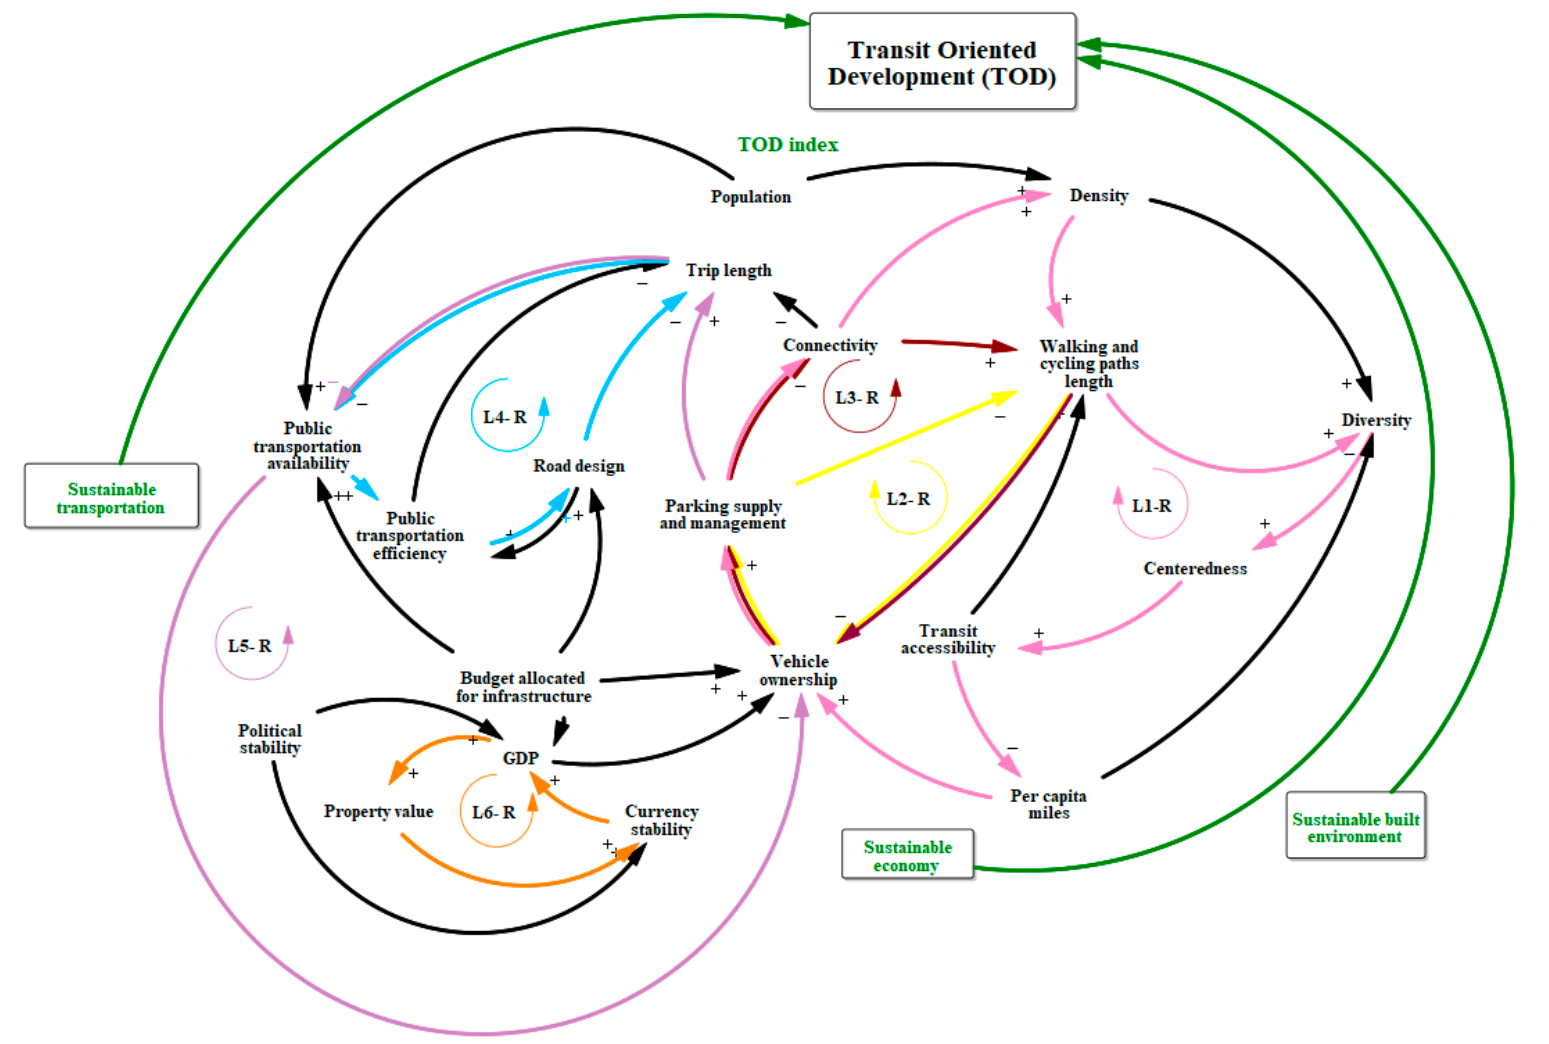
Figure 3. Causal loop diagram (Source: the Authors).